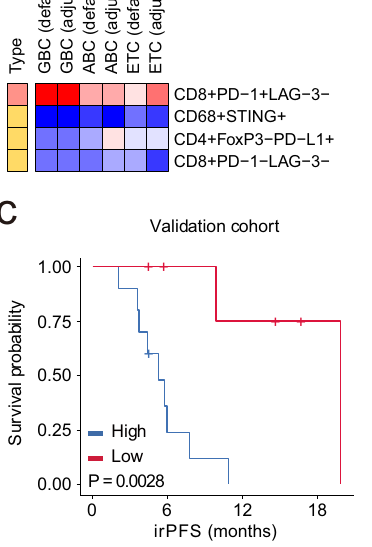
high density of CD4 + FoxP3 − PD-L1 + T cells 31 .